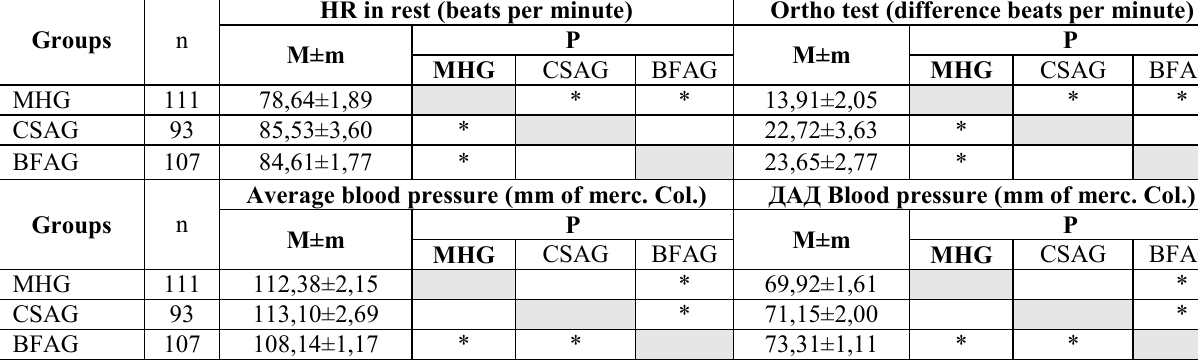
Functional level of different health groups’